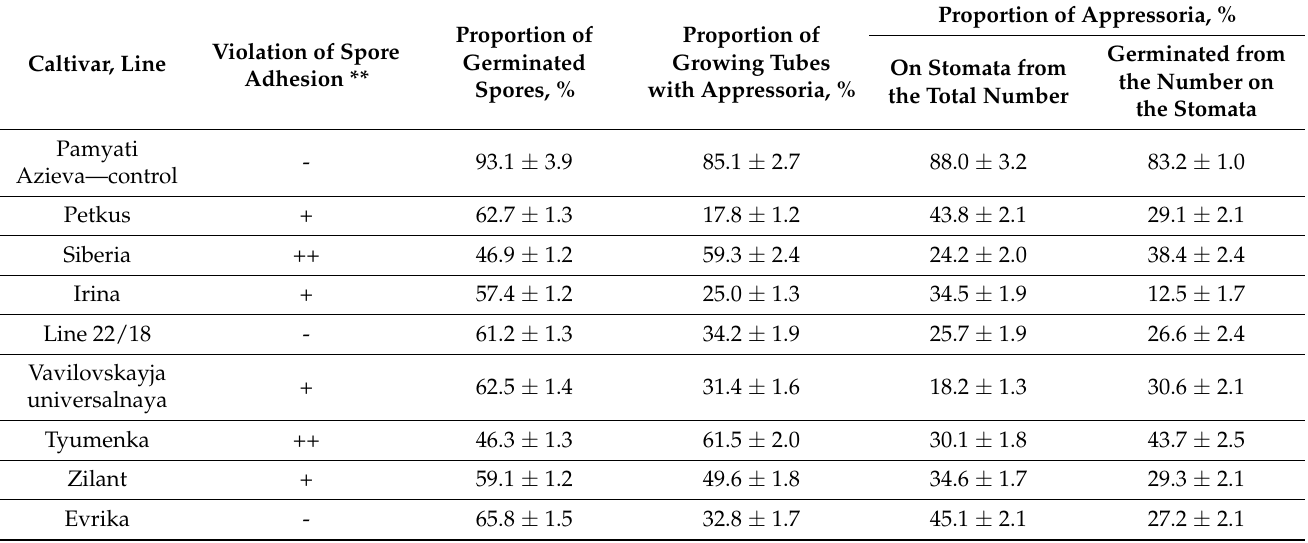
Table 3. Results of the development of infection structures of P. graminis f. sp. tritici on the surfaces of rye plants